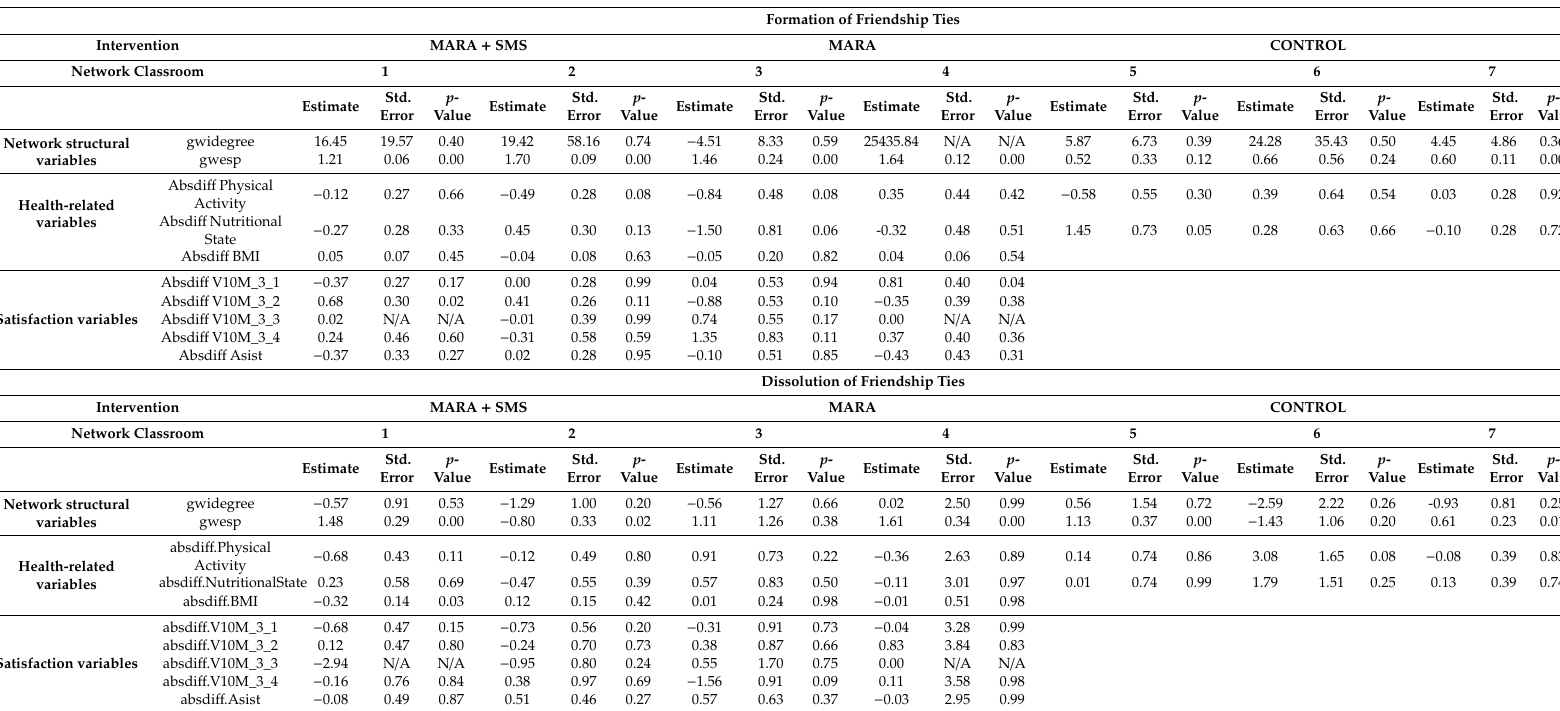
Table A4. Results of STERGM model. Table shows estimate value of the STERGM for each network and its p -value. FormationofFriendshipTies